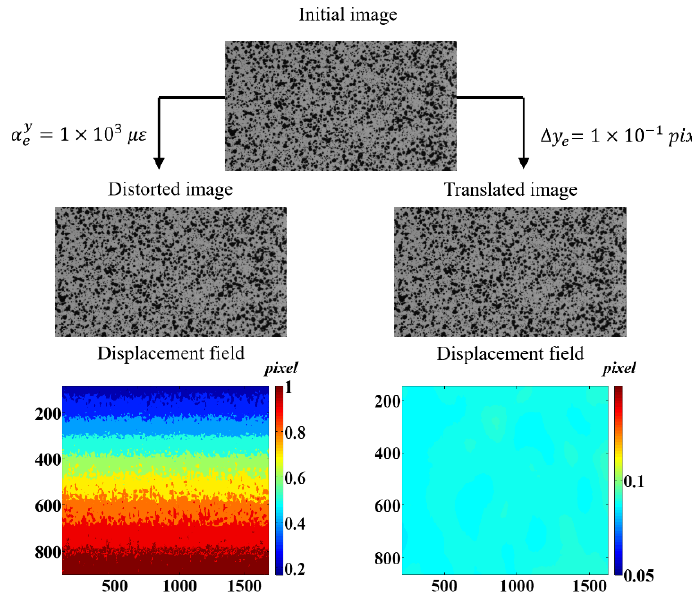
Figure 9. Investigation of the relationship between the image error and measurement error of image analysis methods with DIC as an example.